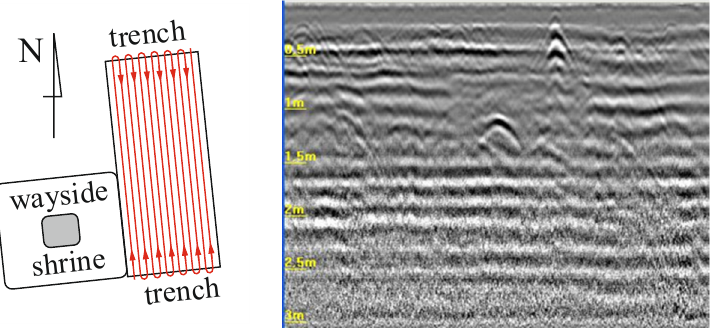
Figure 3. Measurement plan and example of the one-path scanning result (B-scan). Red lines indicate scanning directions.